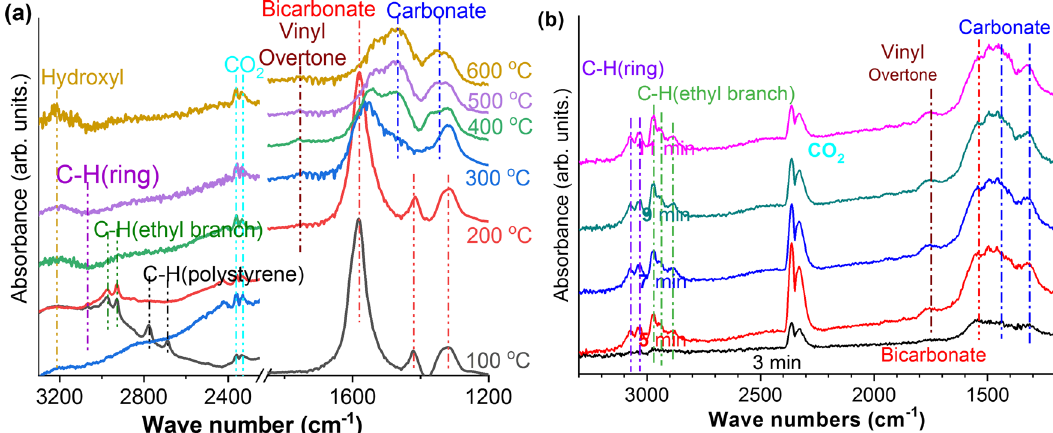
Fig. 5 In situ IR spectra analysis. In situ IR spectra collected during a TPSR on (Ca/Mn) 1 − x O@KFeO 2 from 100 to 500 °C and b isothermal ethylbenzene ODH on fully oxidized (Ca/Mn) 1 − x O@KFeO 2 at 500